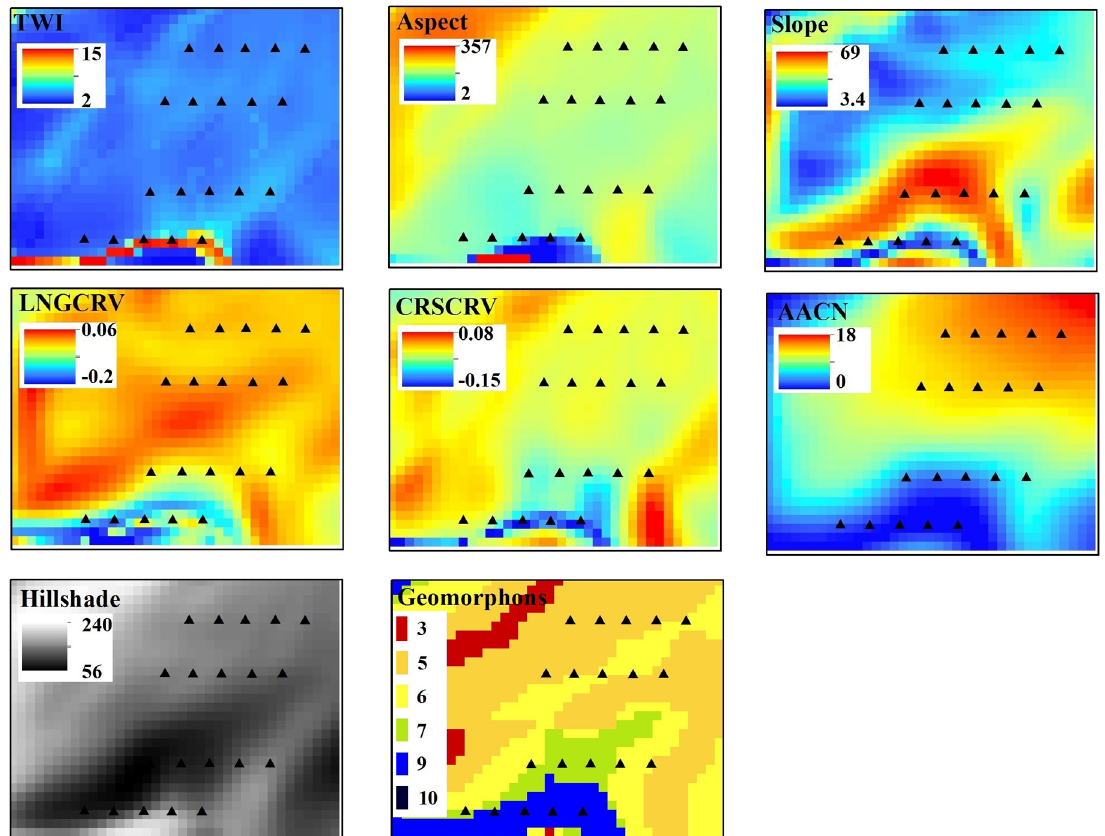
Figure 2 - Terrain attributes obtained from a Digital Elevation Model of 3 m